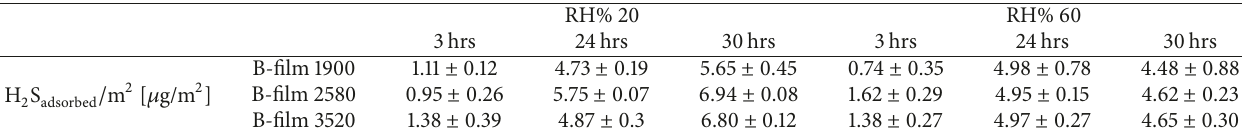
/ m 2 ). The bag tested was without any film inside (B-no Table 4: Averaged data of the amount of H 2 S adsorbed per surface unit (H 2 S adsorbed film)andwiththefilminside.Thesurfaceoftheinternalfilmsheetwasequalto1900cm 2 (B-film1900),2580cm 2 (B-film2580),and3520cm 2 (B- film 3520), respectively. The data reported are the average of the results from three different tests performed at the same conditions.